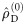
Simulation of a 10-generation breeding program using 200 varieties from the WHEAT data.Simulation of a 10-generation breeding program developed using 200 varieties generated from 2002–2007 WHEAT data with 10 (top left), 50 (top right), 200 (bottom left) and 1000 (bottom right) causal variants. The decay curves, the ρ^D(0) and the ρ^D(m) are in blue, and their linear interpolation (ρ^L) is shown as a dashed blue line. The open green circles are predictive correlations for the simulated populations, and the green solid points are the mean (F^ST,ρ¯) for each generation.